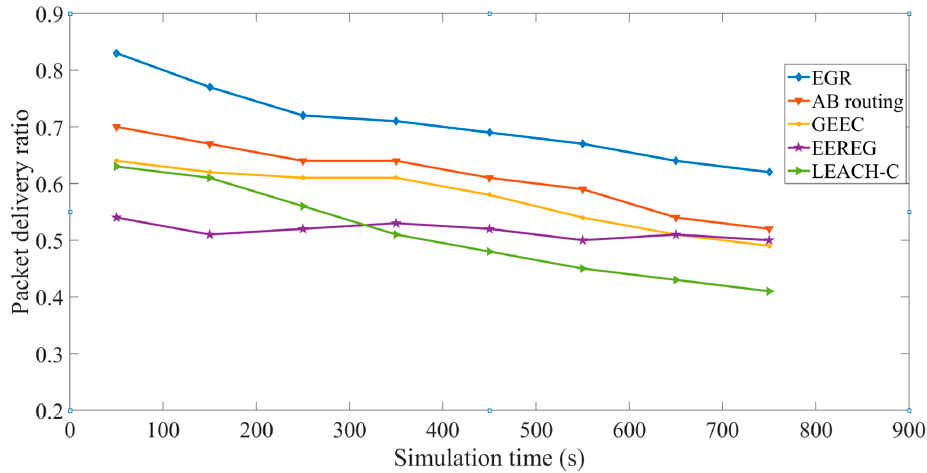
Figure 19. Packet delivery ratio.